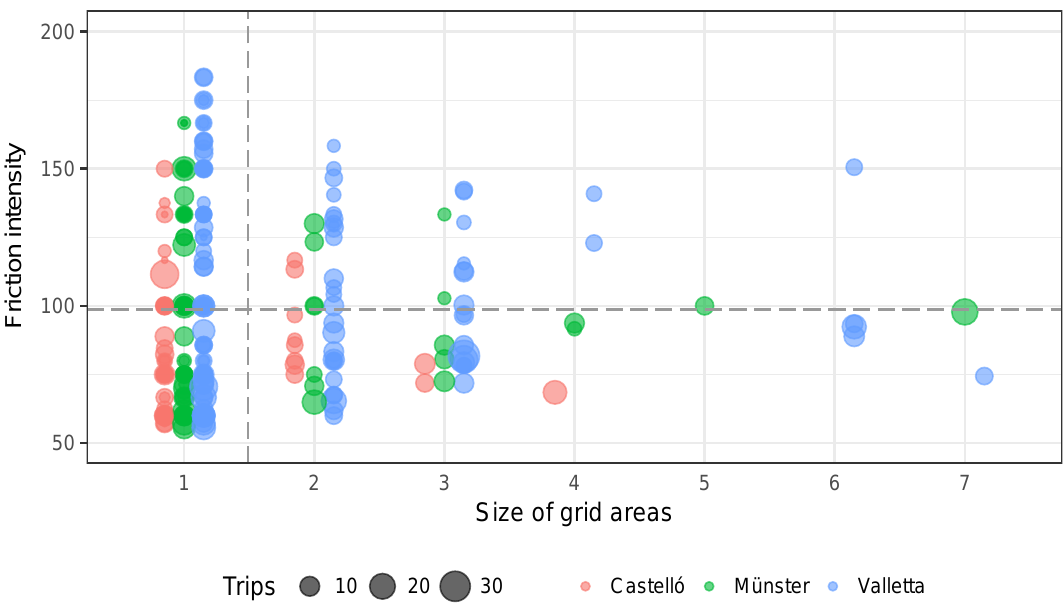
Figure 5. Trips and segments per trip in the three cities.